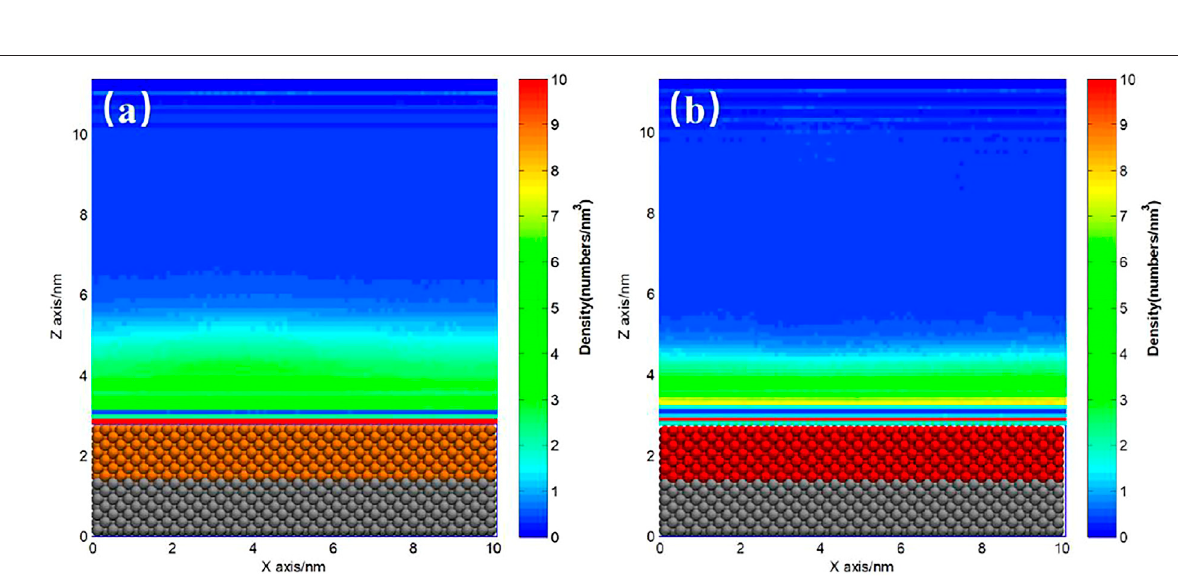
Frontiers in Materials |